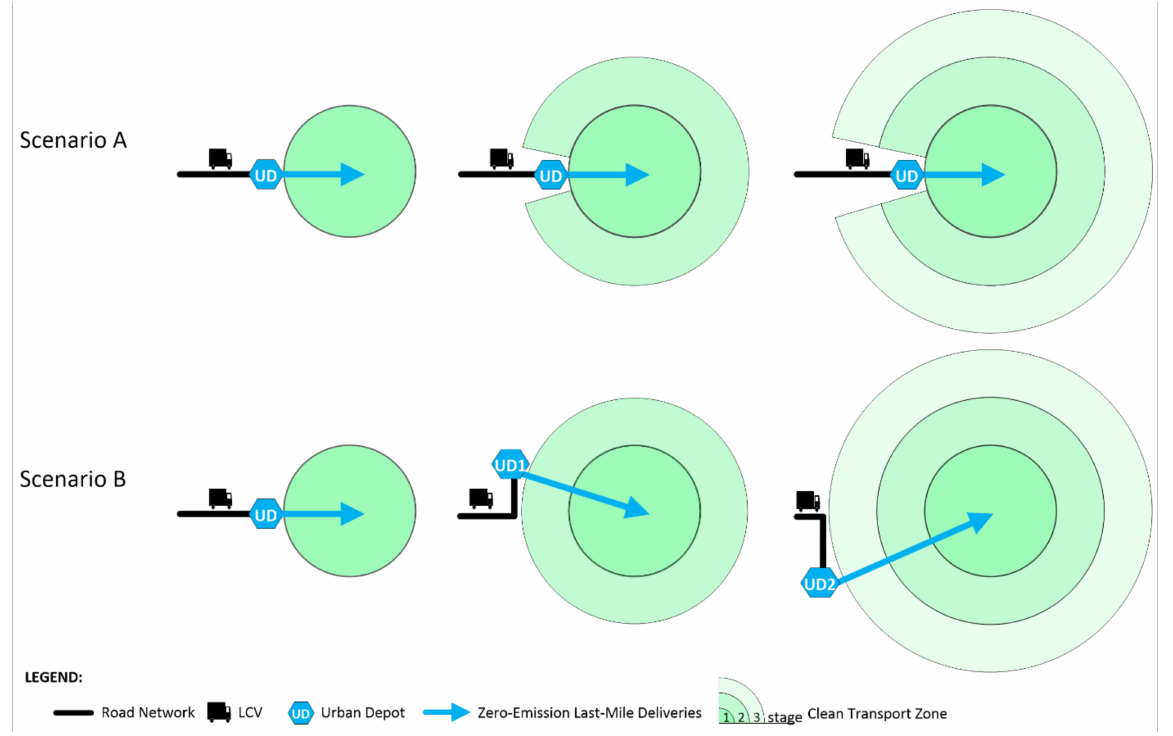
Figure 5. Scenarios of CTZ spatial expansion in variant